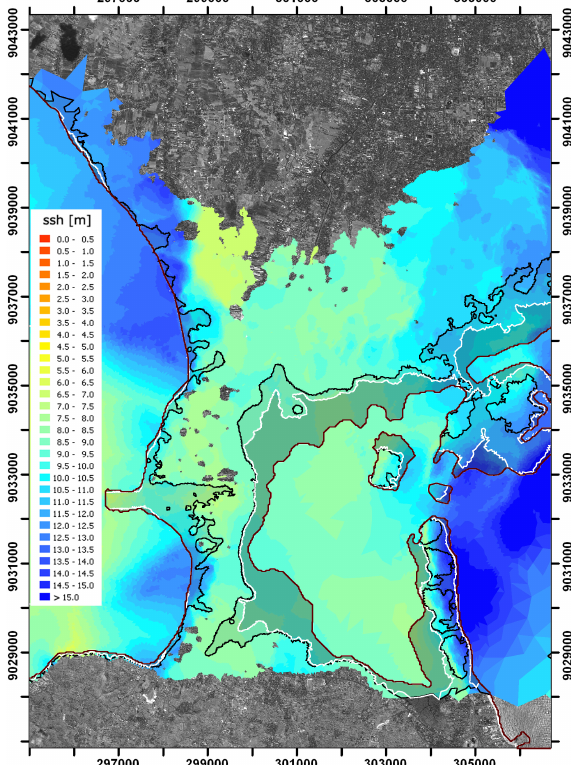
Fig. 13. Worst case scenarios for Kuta. Coloured area: sea surface heights of scenario 039 10 mw9.0, black line: inunda- tion of scenario 041 12 mw8.5, white line: inundation of sce- narios 041 14 mw8.0 (tsunami approaching from the south) and 039 12 8.0 (from south-easterly direction), red line: